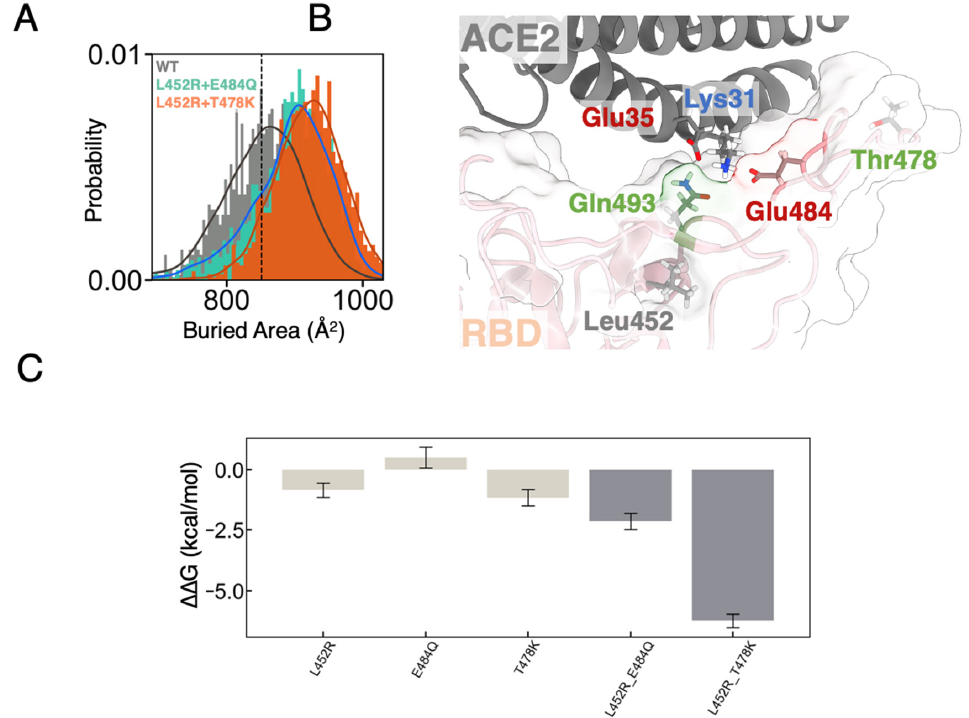
Figure 2. ( A ) Buried area between RBD and ACE2 measured from MD simulations. Dotted line indicates measurement for the crystal structure (PDB: 6M0J). ( B ) Residual interaction network at the binding interface between RBD and ACE2. ACE2 was shown as grey cartoon and RBD was shown as pink cartoon with white transparent molecular surface. ( C ) Change in BFE of mutated RBDs for ACE2. Error bars were the standard